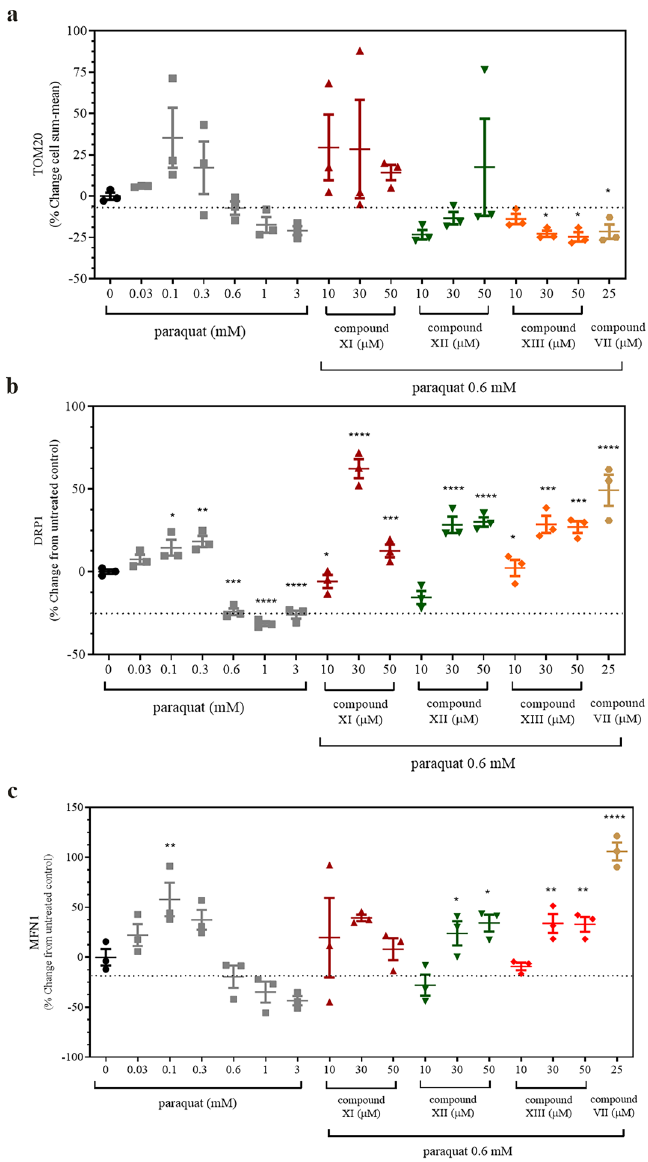
Figure 7. Paraquat-induced changes on mitochondrial dynamics. A549 cells were exposed to paraquat for 48 h and/or pre-treated with OGG1 activators for 4 h. Images were obtained and from these images graphical representations are displayed for ( a ) TOM20, ( b ) DRP1 and ( c ) MFN1. The dotted lines refer to the level of change induced by 0.6 mM paraquat. Values represent the average of two independent experiments in triplicate. Statistical significance was conducted and denoted as described in Fig. 6. For compound VII in ( a ), p = 0.042. In ( b ) p values from left to right side of the panel denoted by the asterisks equal 0.0138, 0.0023, 0.0002, < 0.0001, < 0.0001, 0.0242, 0.0002, 0.0003 and < 0.0001, respectively. For ( c ) the asterisks from left to right of the panel represent p -values of; 0.0099, 0.0498, 0.0183, 0.0045, 0.005 and < 0.0001,